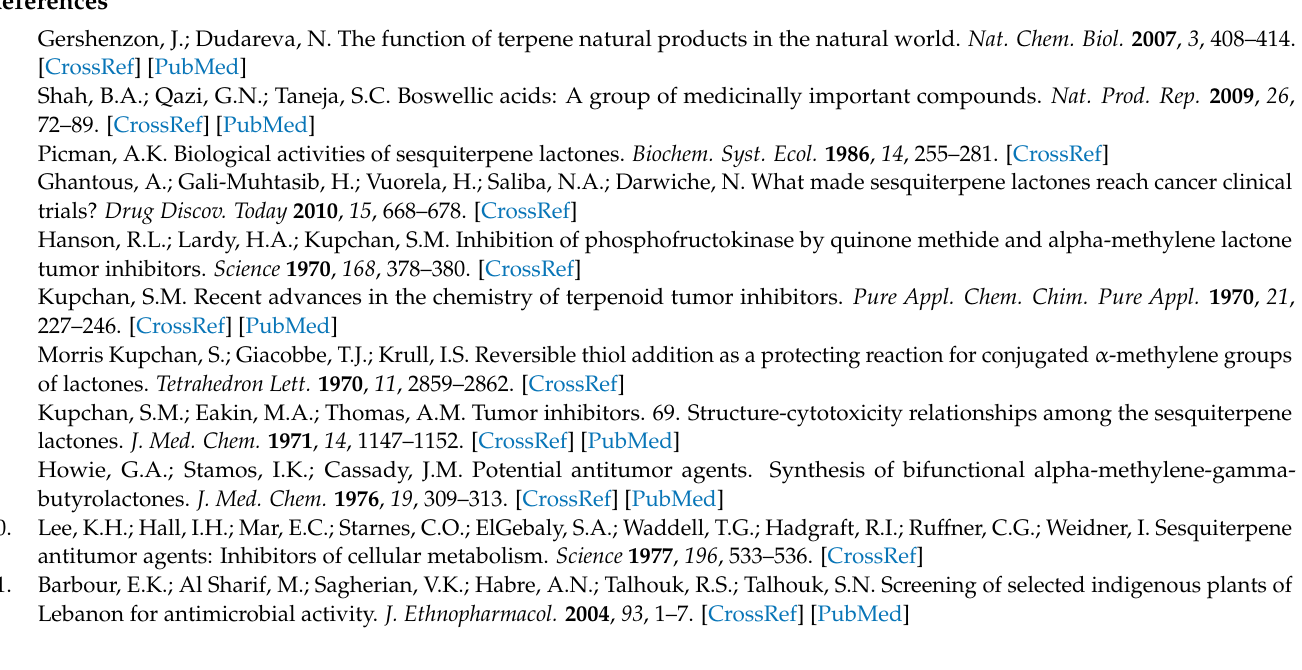
Sal-B and its most potent derivatives on the growth of NCM460 cells. Figure S9: Cytotoxic effect of Sal-A and Sal-B on HCT116 cells. Figure S10: Cytotoxic effect of Sal-A derivatives on HCT116 cells. Figure S11: Cytotoxic effect of Sal-B derivatives on HCT116 cells. Figure S12: 1 H NMR spectrum of compound 1 (CDCl3, 500 MHz.) Figure S13: 13 C NMR spectrum of compound 1 at 20 K (CDCl3, 500 MHz) Figure S14: 1 H NMR spectrum of compound 2 (CDCl3, 500 MHz) Figure S15: 13C NMR spectrum of compound 2 at 20 K (CDCl3, 500 MHz). Figure S16: 1 H NMR spectrum of compound 3 (CDCl3, 500 MHz) Figure S17: 13 C NMR spectrum of compound 3 at 20 K. Figure S18: 1 H NMR spectrum of compound 4 (CDCl3, 500 MHz). Figure S19: 13 C NMR spectrum of compound 4 at 20 K (CDCl3, 500 MHz). Figure S20: 1 H NMR spectrum of compound 5 (CDCl3, 500 MHz). Figure S21: 13 C NMR spectrum of compound 5 at 20 K (CDCl3, 500 MHz). Figure S22: 1 H NMR spectrum of compound 6 (CDCl3, 500 MHz). Figure S23: 13 C NMR spectrum of compound 6 at 20 K (CDCl3, 500 MHz). Figure S24: 1 H NMR spectrum of compound 7 (CDCl3, 500 MHz). Figure S25: 13 C NMR spectrum of compound 7 at 20 K (CDCl3, 500 MHz). Figure S26: 1 H NMR spectrum of compound 8 (CDCl3, 500